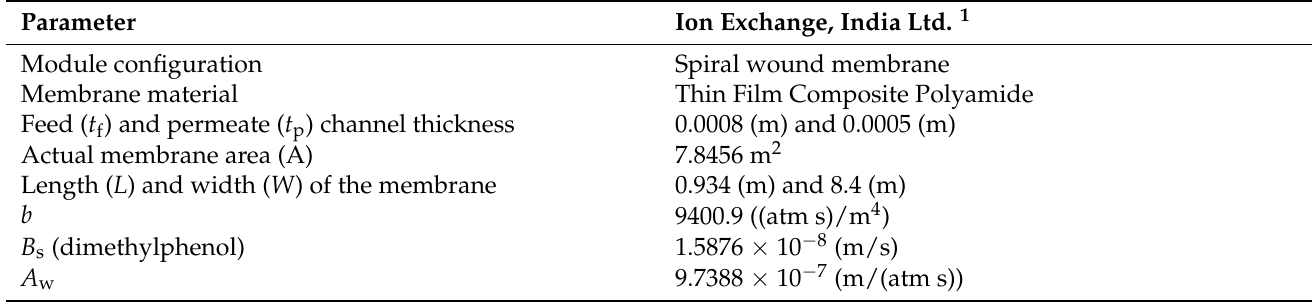
Table 1. Membrane characteristics, dimensions, and transport parameters [33].